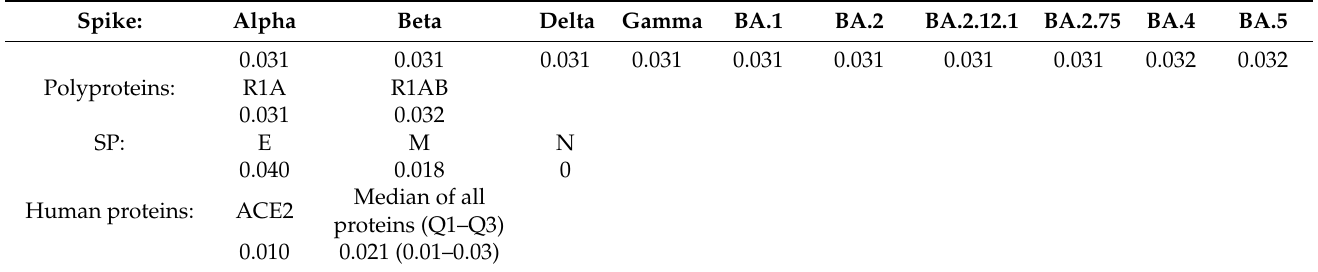
Table 1. Relative Cys content of SARS-CoV-2 proteins (spike variants, polyproteins, and structural proteins SP), human ACE2, and average content of all human proteins (median and